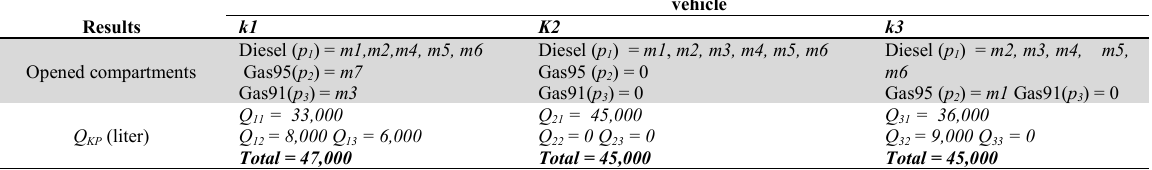
The opened compartments of each selected vehicle for the case study